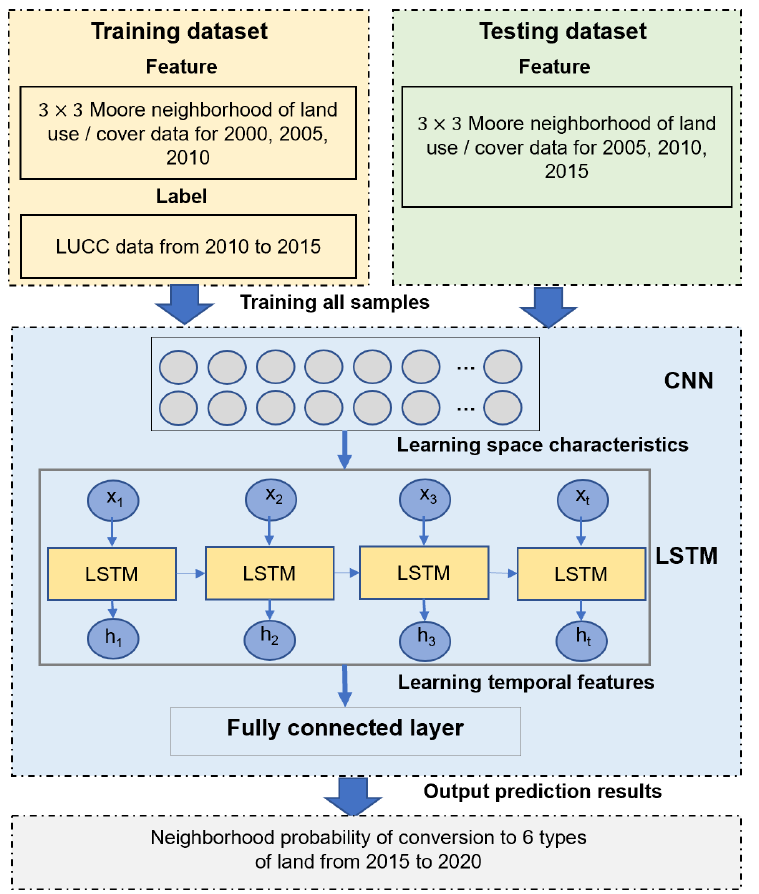
Figure 6. Flowchart of extracting neighborhood probability from CNN-LSTM